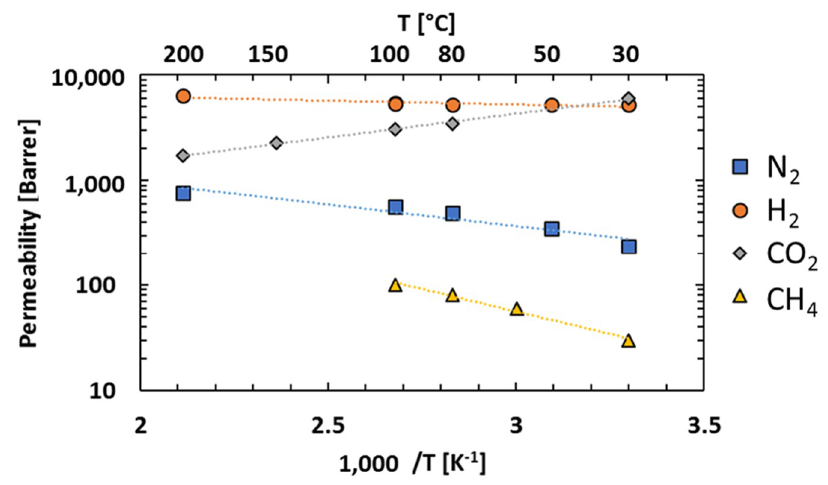
Figure 7. Permeability coefficients of N 2 , CO 2 , H 2 and CH 4 as a function of the inverse absolute temperature (at 1 bar) (The dotted lines represent the best curve-fits of the experimental data with Arrhenius equation).